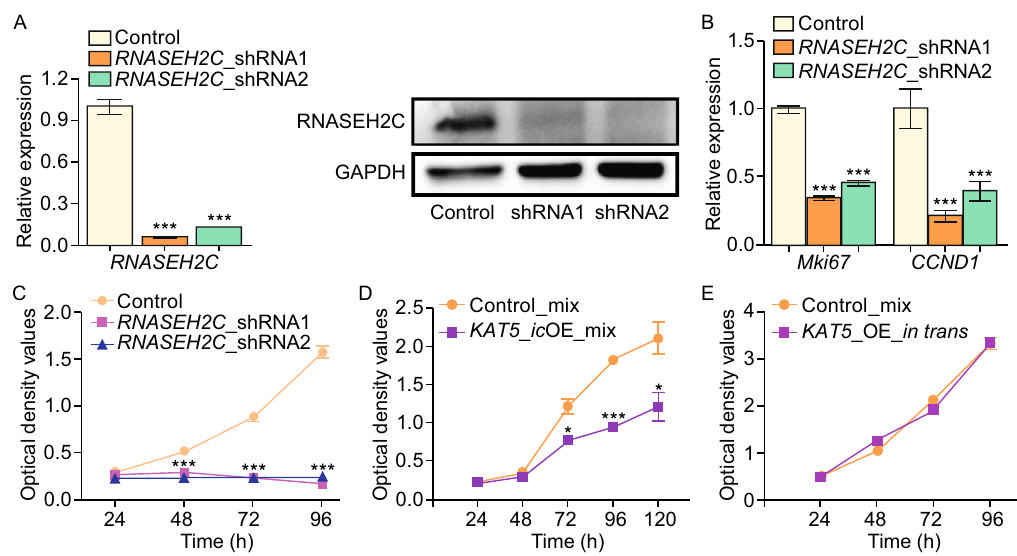
Figure 4. Reduced RNASEH2C protein abundance leads to slower cell proliferation rate. (A) qRT-PCR (left) and Western-blot (right) for RNASEH2C after knockdown RNASEH2C by two shRNAs. GAPDH served as the internal control. (B) Relative expression level of Mki67 and CCND1 evaluated by qRT-PCR. (C) Cell proliferation rate in RNASEH2C -knockdown cells compared to control cells assayed by CCK-8 kit. (D) CCK-8 assay for cells in cis overexpressing of KAT5 ( KAT5 _icOE_mix) and control 293T cells. (E) Comparison of cell growth rate between control cells and cells in trans over-expressing KAT5 ( KAT5 _OE_ in trans ) by CCK-8 assay. Overexpression of KAT5 in trans was performed using lentivirus